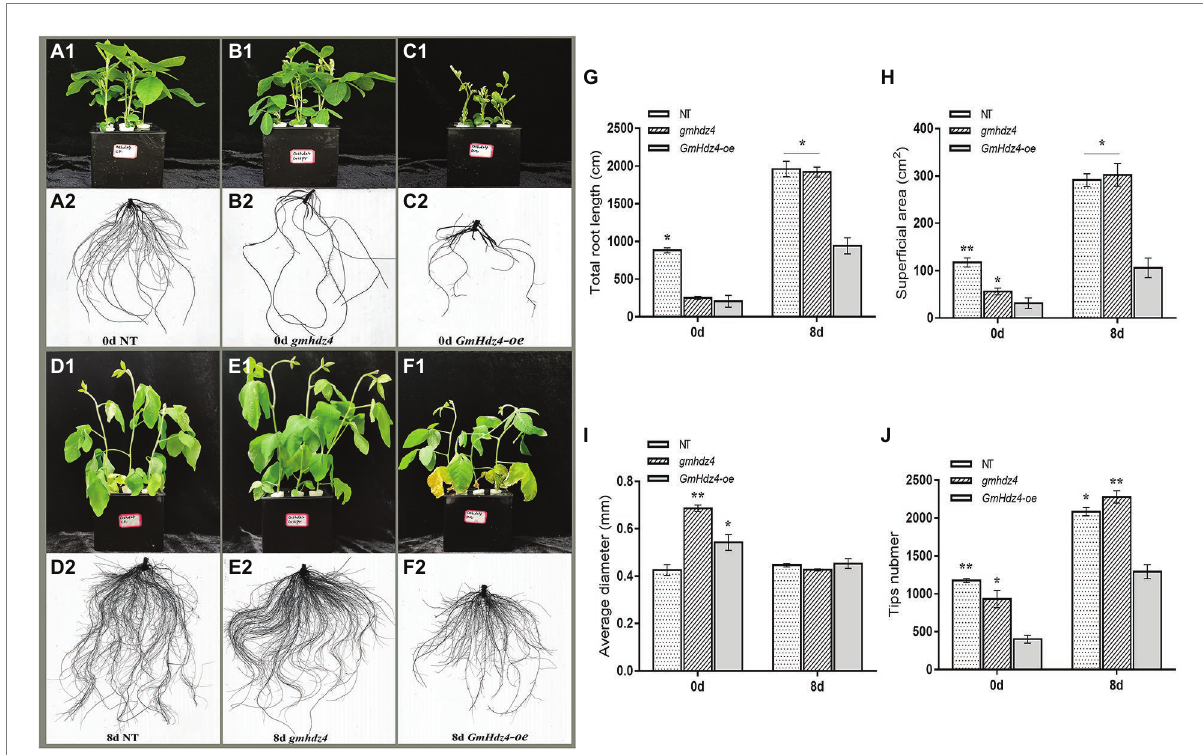
FIGURE 5 The phenotype and root system architecture among NT, gmhdz4 chimeric lines, and GmHdz4-oe chimeric lines. Phenotypic comparison of transgenic hairy roots chimera and NT soybeans before and after PEG treatment (A1–F2) . The root system architecture analysis of total root length (G) , superficial area (H) , average diameter (I) , and tip numbers (J) . NT, non-transgenic soybeans; gmhdz4 , gene-editing chimeric line; GmHdz4- oe, overexpression GmHdz4 chimeric line. At least three biological replicates were performed, and the data before (0d) and after (8 days) treatment were statistically analyzed, respectively. Significant differences are indicated by * and ** for p < 0.05 and p < 0.01, respectively, according to Duncan’s